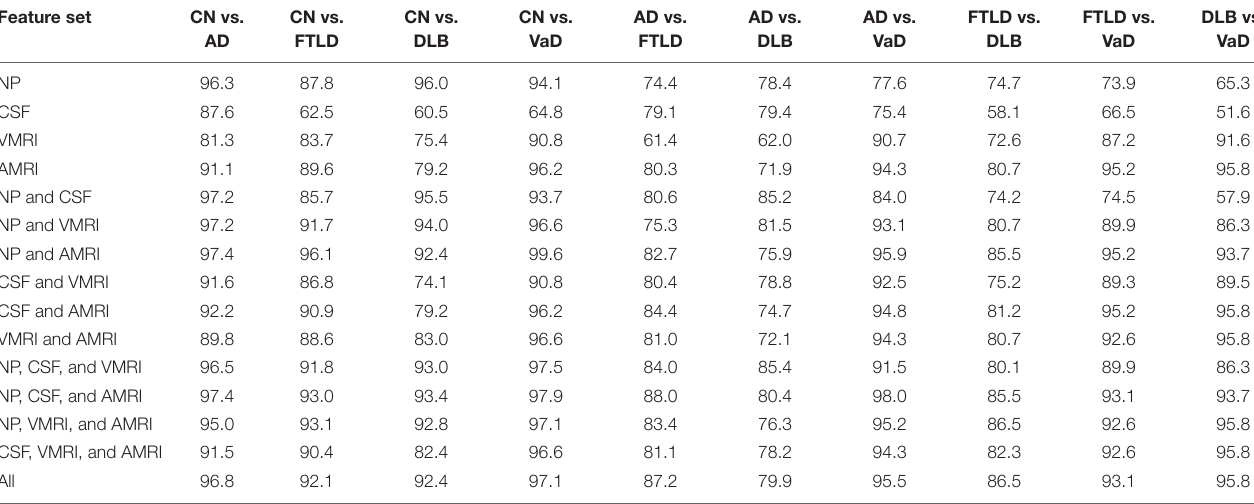
TABLE 5 | Balanced accuracies [%] using different subsets of the data sources for all possible two-class classification problems. Feature set CN vs. AD